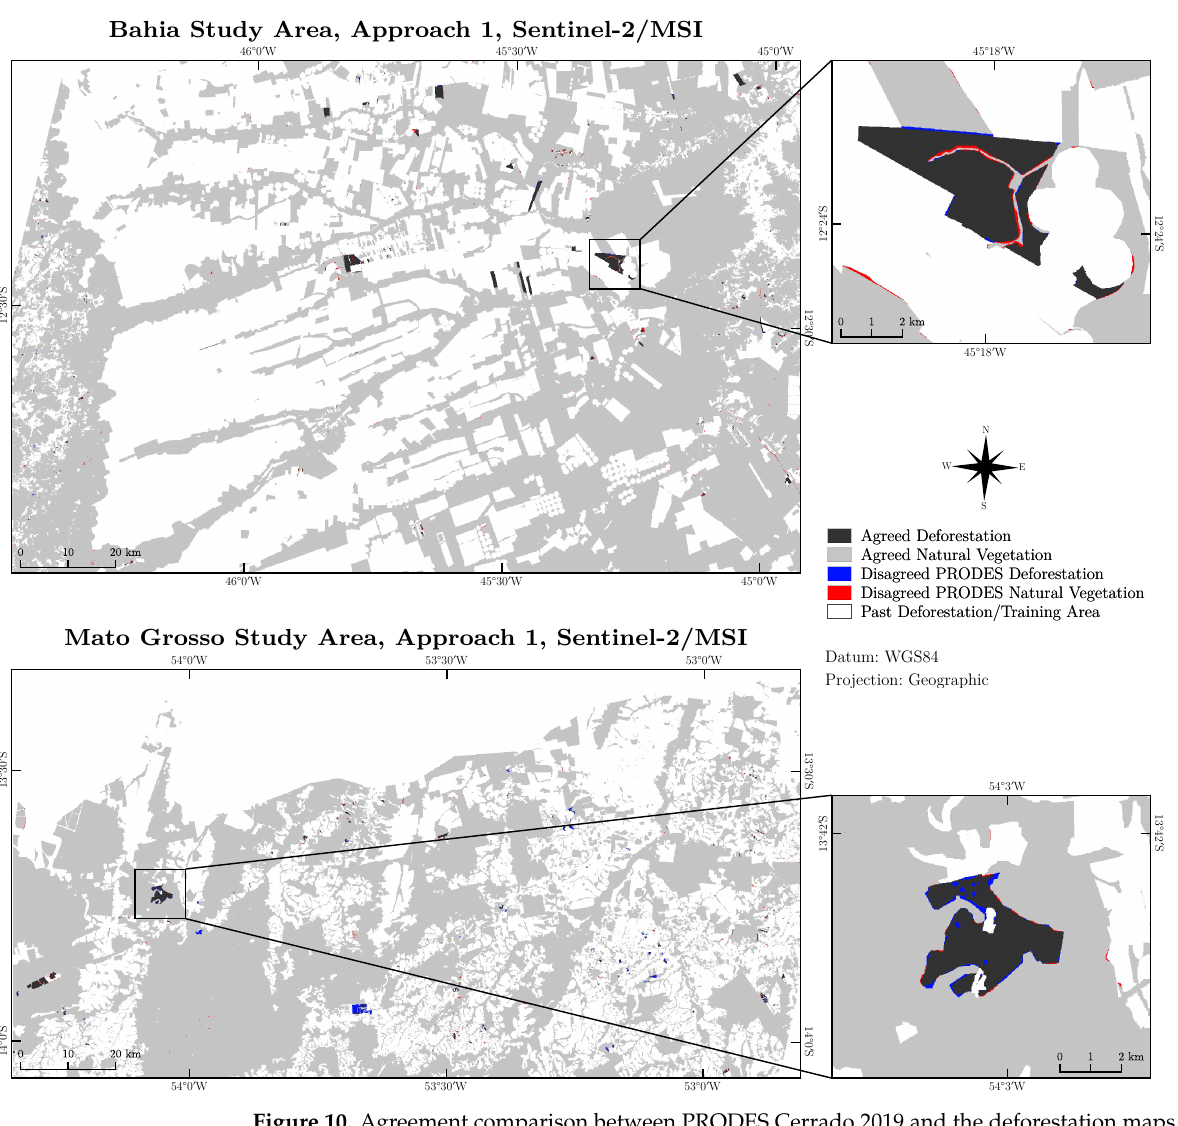
Figure 10. Agreement comparison between PRODES Cerrado 2019 and the deforestation maps using Sentinel-2/MSI and training samples based on Approach